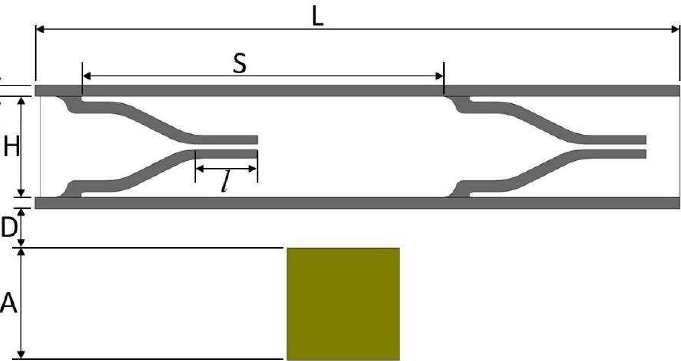
Figure 3. Duckbill valve model in 2D with its main dimensions. Table 1. Properties of duckbill valve model.